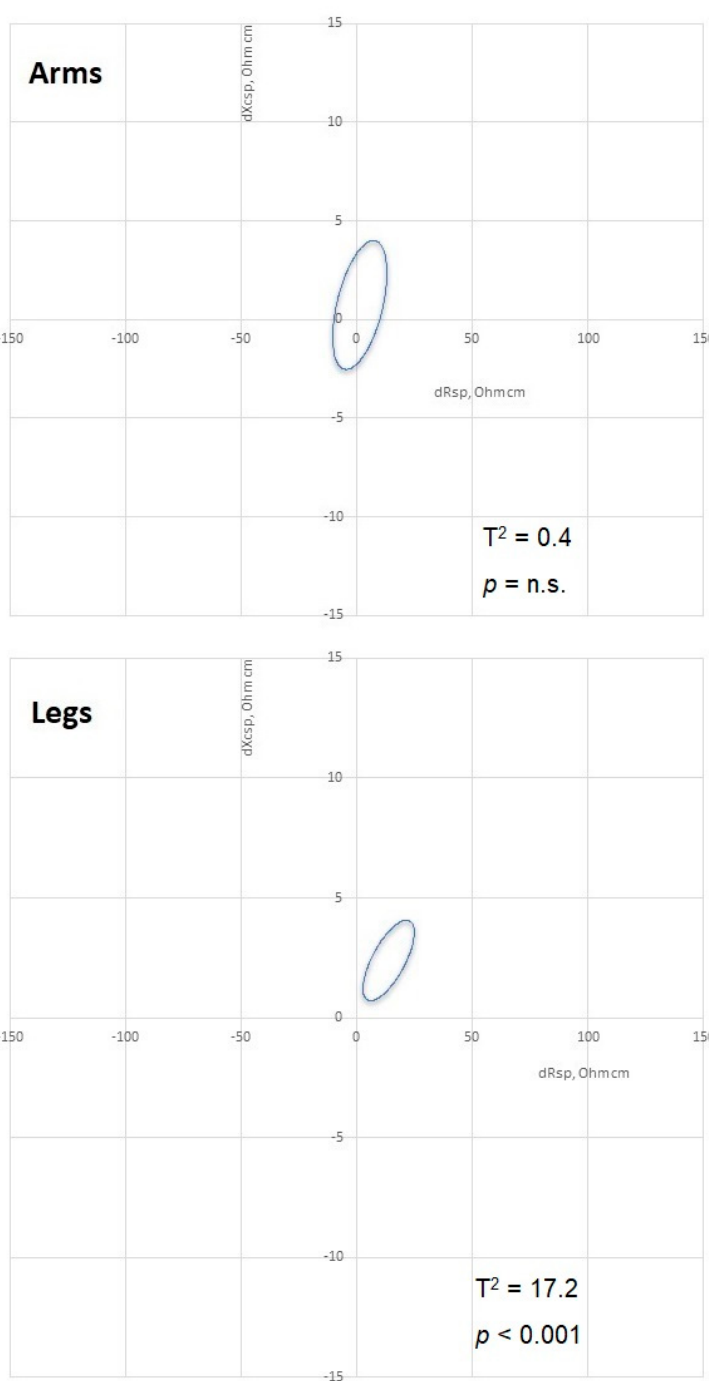
Figure 2. Paired data RXc graphs of the comparison between dominant and non-dominant arms and between right and left legs. Rsp: specific resistance; Xcsp: specific reactance.